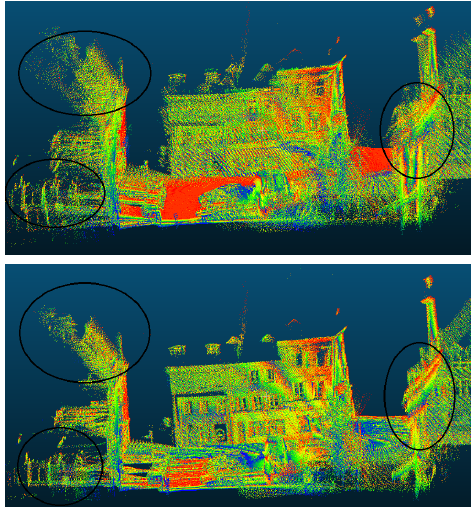
Figure 8. Real point cloud #2: top, before optimization of the parameters; bottom, after optimization. The two images have the same point of view.